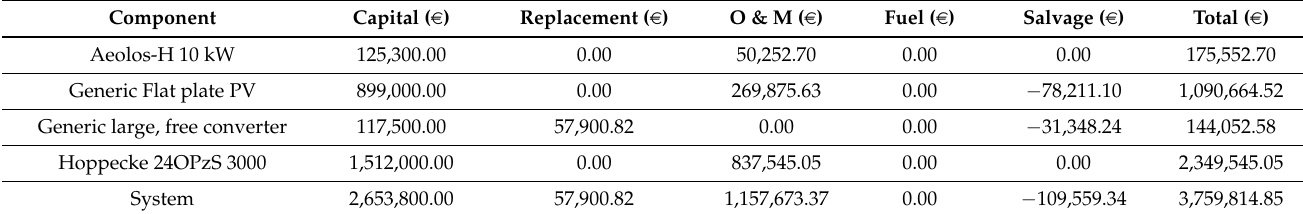
Table 31. Analytical costs of each component Case 1 Scenario 3.